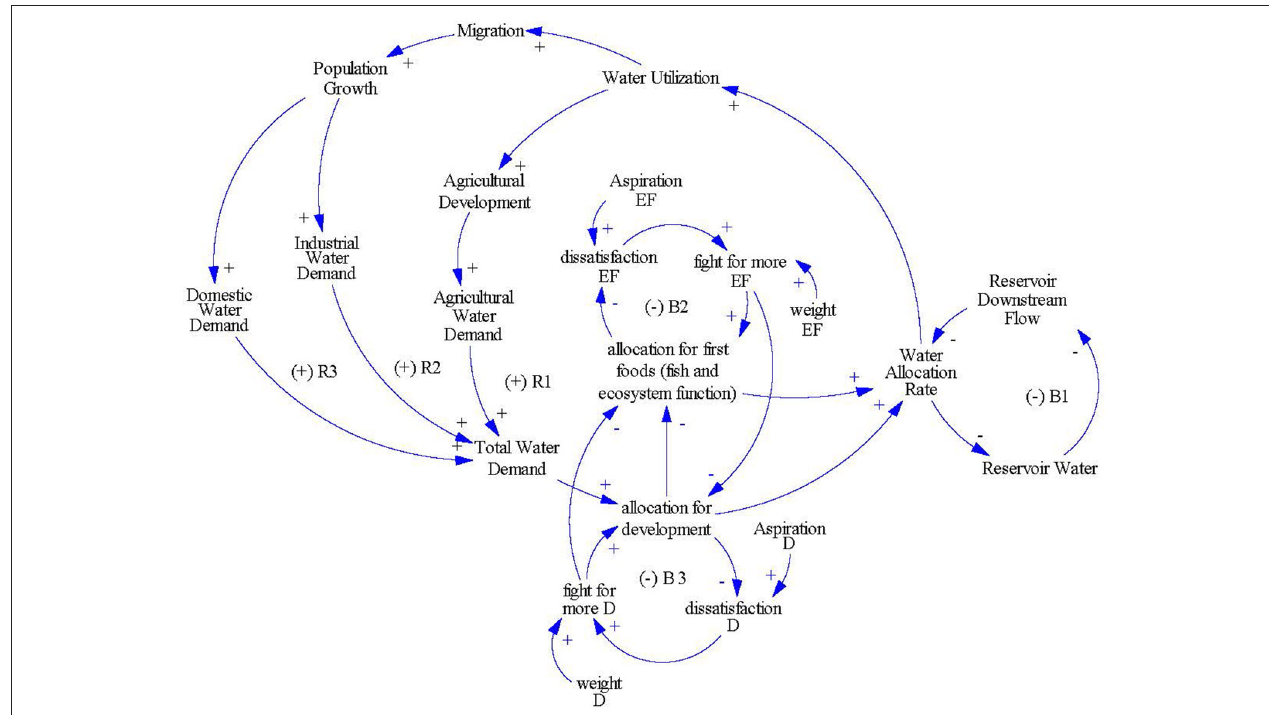
FIGURE 4 | Conceptual map of FEW system demands and allocations based on distribution between users that prioritize water for development (D) and users that prioritize water for fish and ecosystem function (EF). R and B represent positive and negative feedback loops.